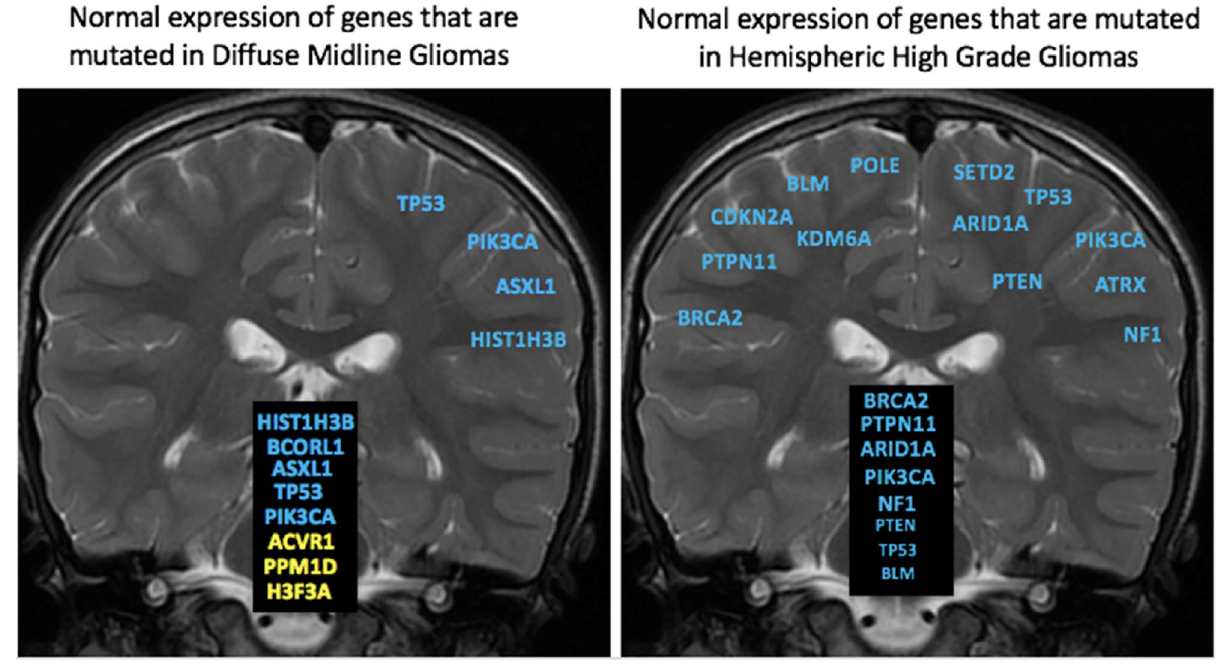
Figure 3. Summary of gene expression profiles of genes that are commonly mutated in diffuse midline gliomas and in hemispheric